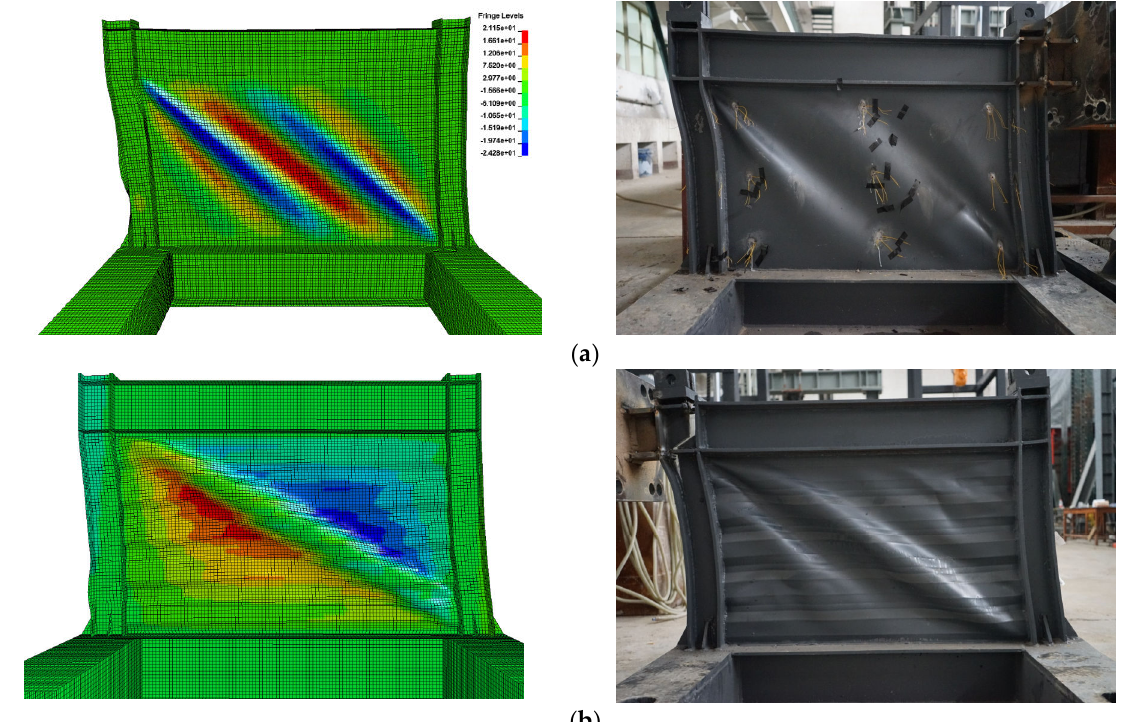
Figure 9. Comparison of the final failure of specimens ( a ) C and ( b ) D. Table 4. Parametric